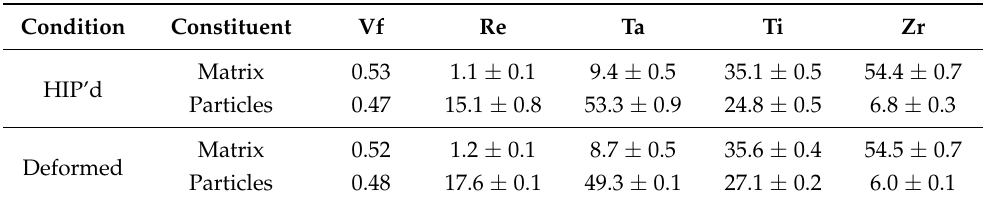
Figure 11. ( a ) EBSD map of BCC (red) phases and ( b ) combined inverse pole figure (IPF) orienta- tion map of the BCC matric phase and particles. An IPF color-coding map is shown as an insert in ( b ). The maps were taken from the surface area of Re 0.3 TaTiZr shown in Figure 10b. Grain bounda- ries with misorientations >10° are shown as dark lines.